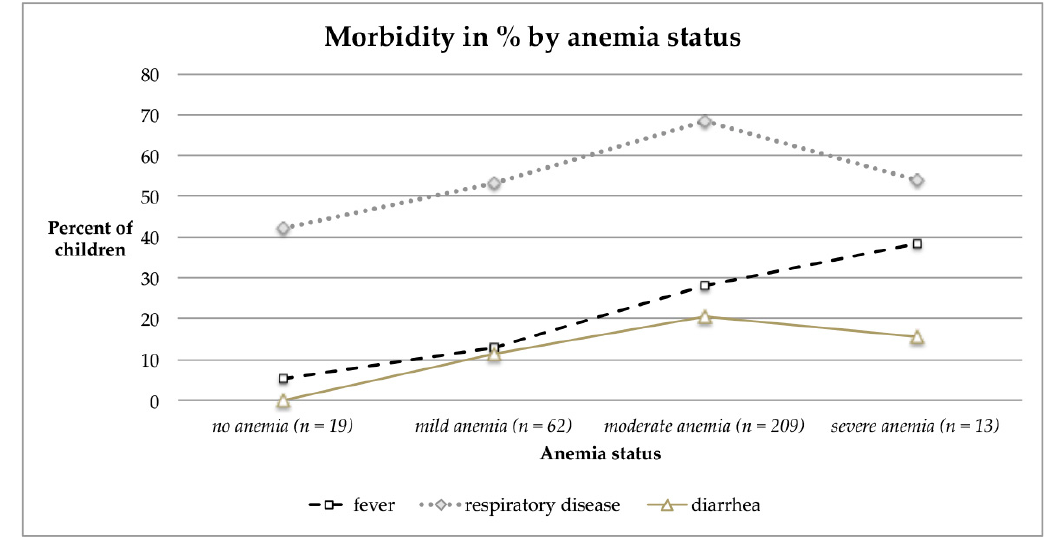
Figure 1. Proportion (%) of children ( n = 303) by age suffering from fever, respiratory disease or diarrhea during the last week prior/or during medical checkup.